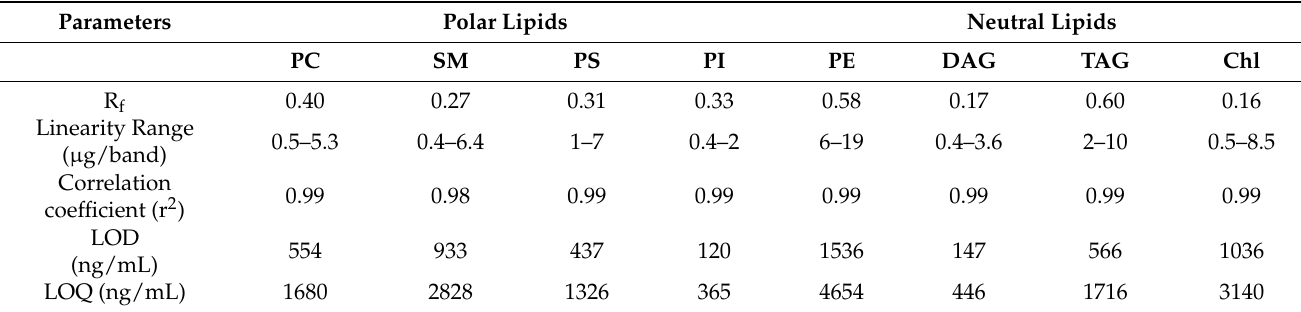
Table 1. HPTLC method parameters for PL and NL